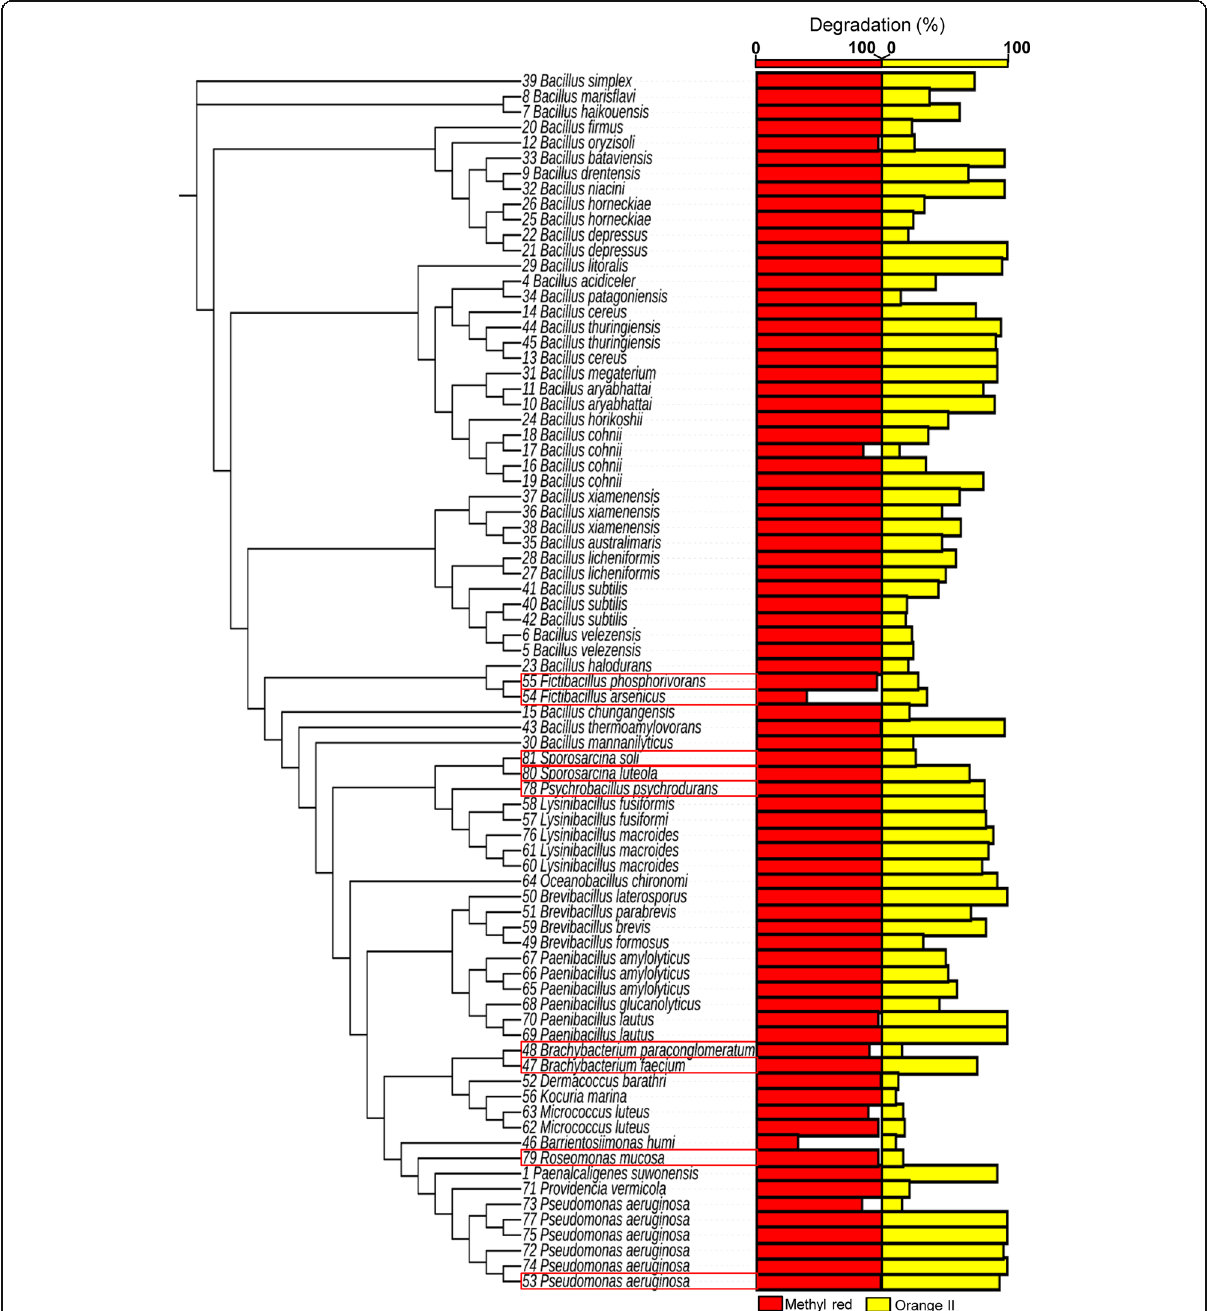
Fig. 2 A phylogeny and degradation of Methyl Red and Orange II of 79 diverse bacteria isolated from tattoo inks. Bacterial isolates with a red color rectangle indicate bacterial species with azo dye decolorization ability, which has not been recognized before, and bars (red and yellow) indicate % azo dye degradation of Methyl red and Orange II,